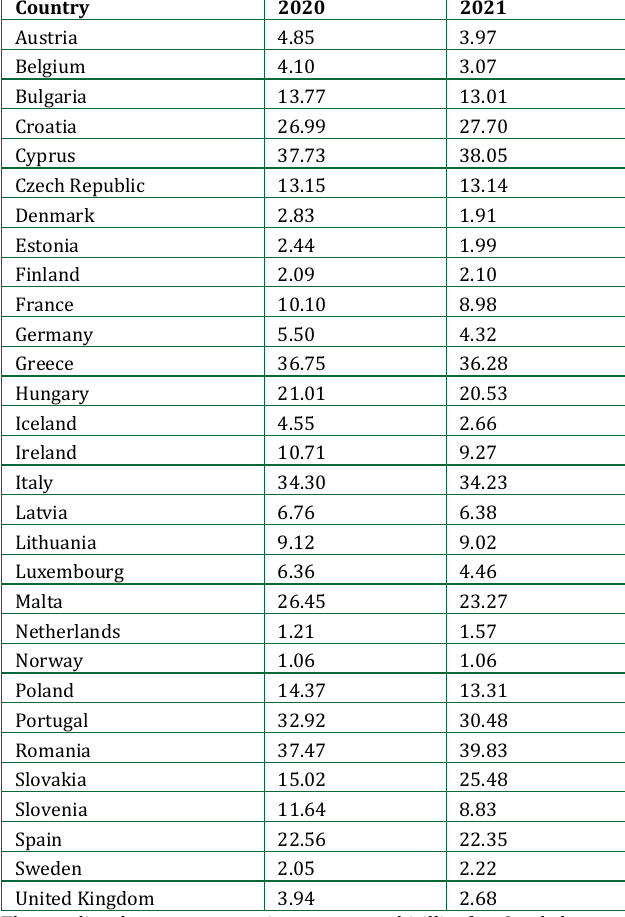
Table 6: Forecasted AMR’s percentage for Staphylococcus aureus